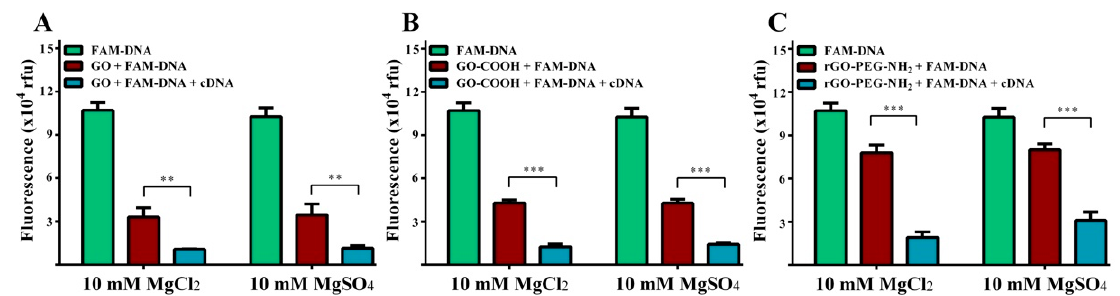
Figure 7. Representation of fluorescence values in the presence of 10 mM MgCl 2 and 10 mM MgSO 4 , for different graphenic species ( A ) GO, ( B ) GO-COOH and ( C ) rGO-PEG-NH 2 and 100 nM FAM-DNA plus100 nM cDNA. Values represent mean ± SD of n = 3. (** p < 0.01, *** p < 0.001).